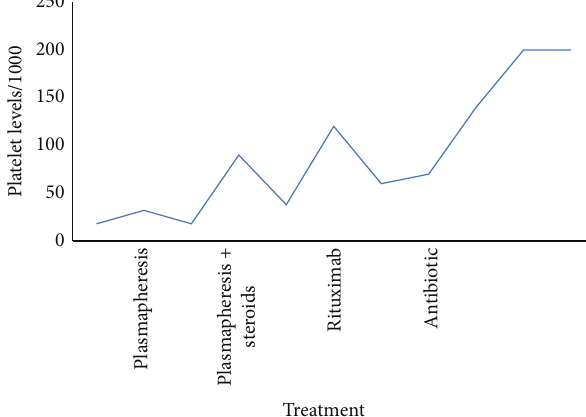
Figure 2: The graph illustrates the patient’s platelet levels (per 1000) with different types of treatments. From the data, it is apparent that after the patient was given antibiotics the platelet levels were both stabilized and remained within normal